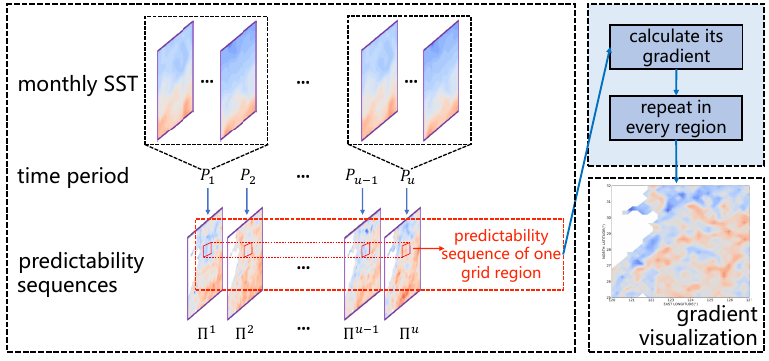
Figure 6. The process for analyzing the dynamics of SST predictability.